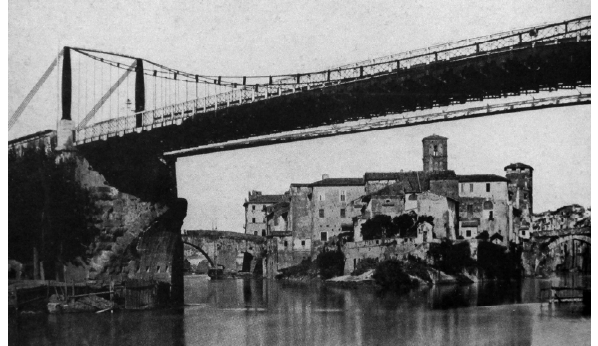
Figure 2. Broken Bridge near Tiber Island (Jodice, 1985)